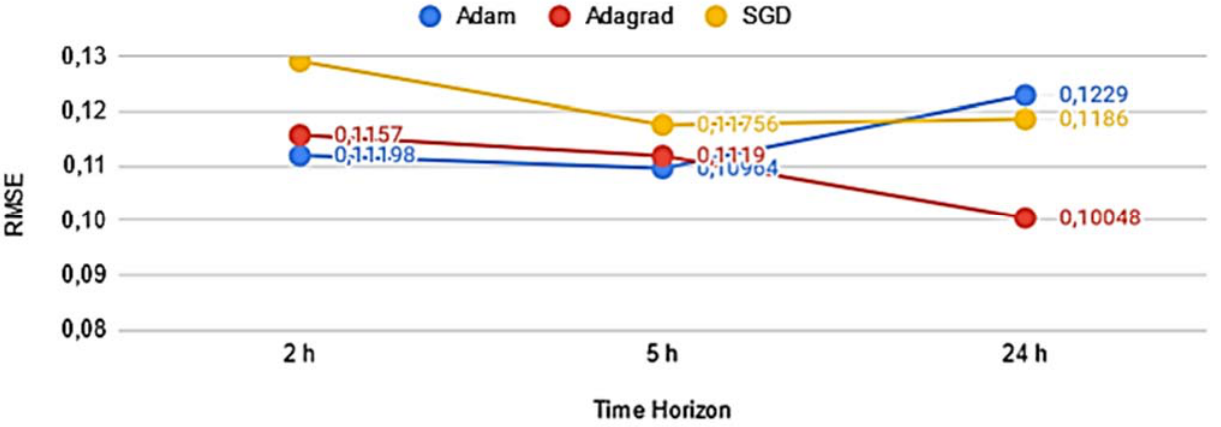
Figure 10. Average RMSE concerning loss function for the validation set on 2 h prediction horizon and 128 neurons per layer.